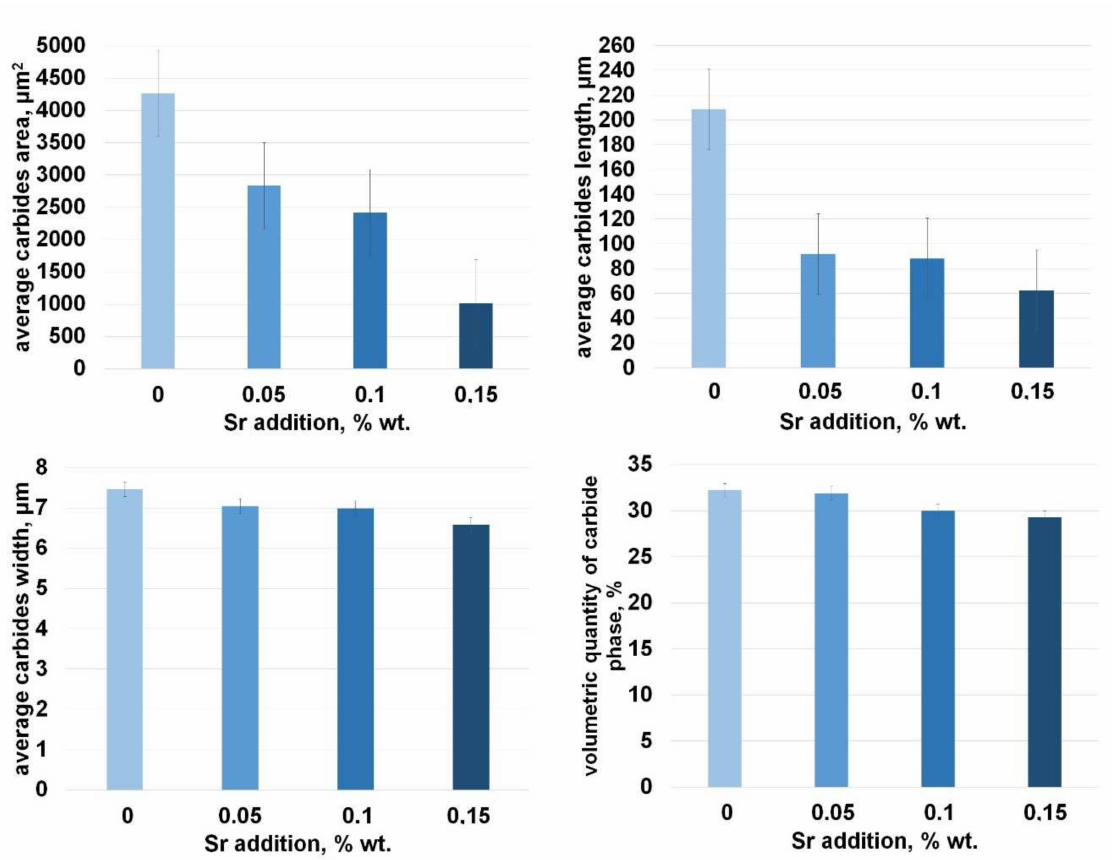
Figure 7. Selected stereological parameters of chromium carbide analysis in a function of added